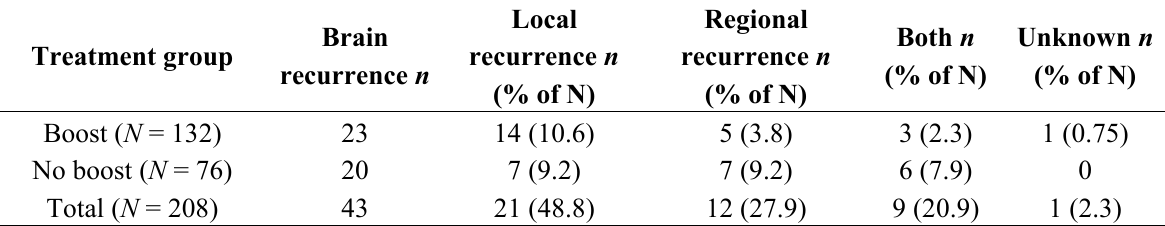
Table 2. Brain, local and regional recurrences organized by radiation boost. N , patient’s number; n , number of